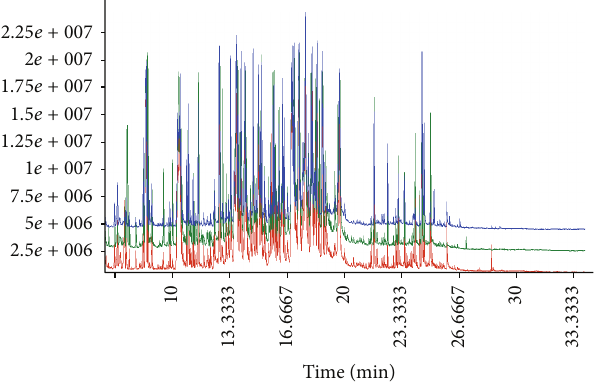
Figure 2: Histological score of the AA rats, # 𝑝 < 0.05 , ## 𝑝 < 0.01 compared with untreated group.